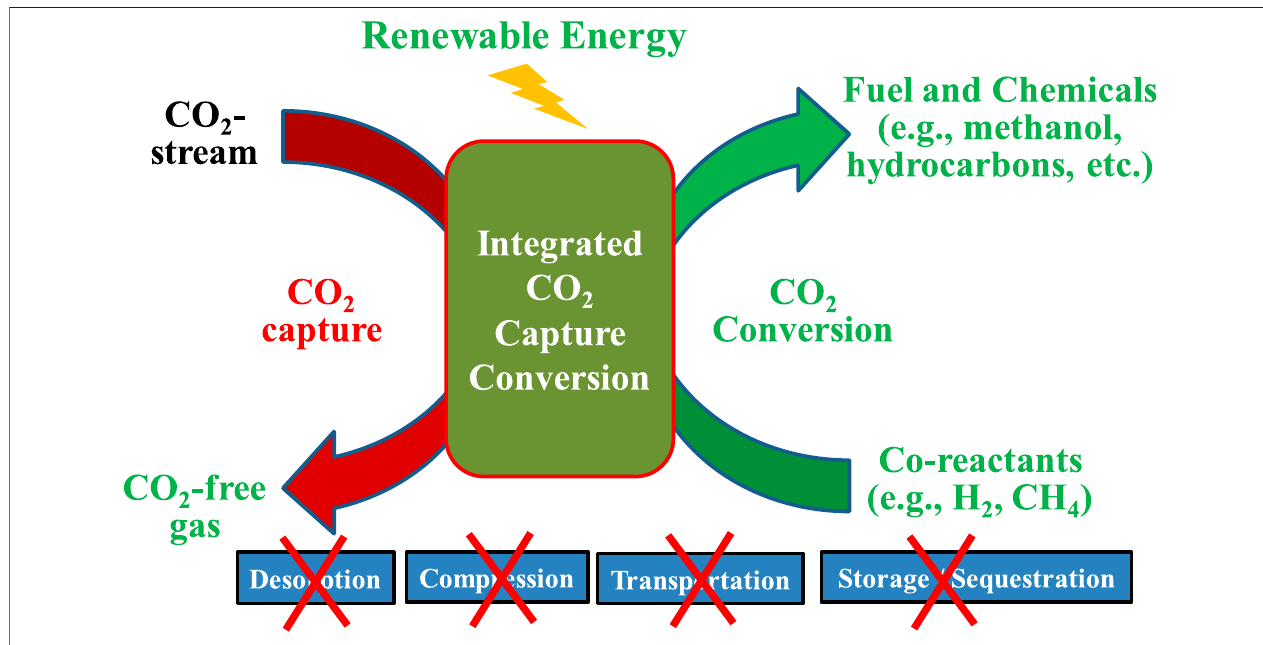
FIGURE 8 | Concept of one step direct integration of CO 2 capture and in situ CO 2